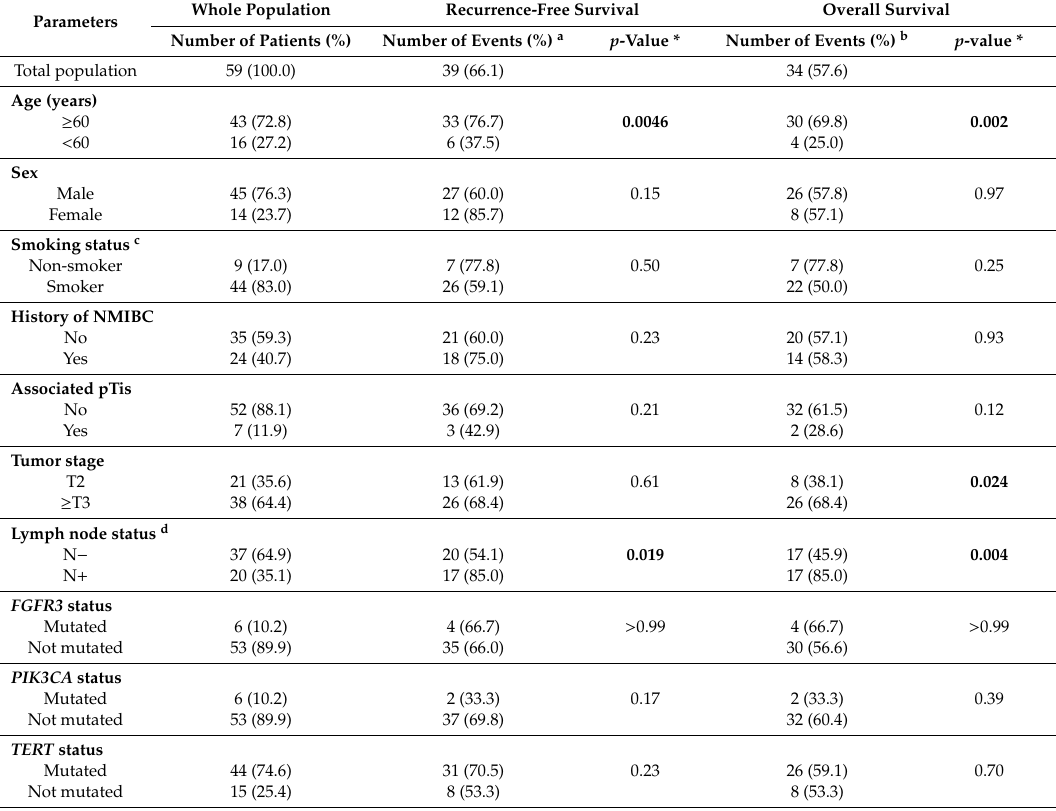
Table 2. Clinical, biological, pathological and survival characteristics of the 59 muscle-invasive bladder cancer